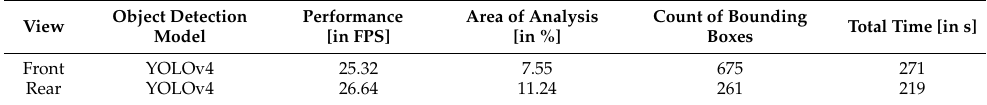
Table 5. General information of Sample scenario #2.